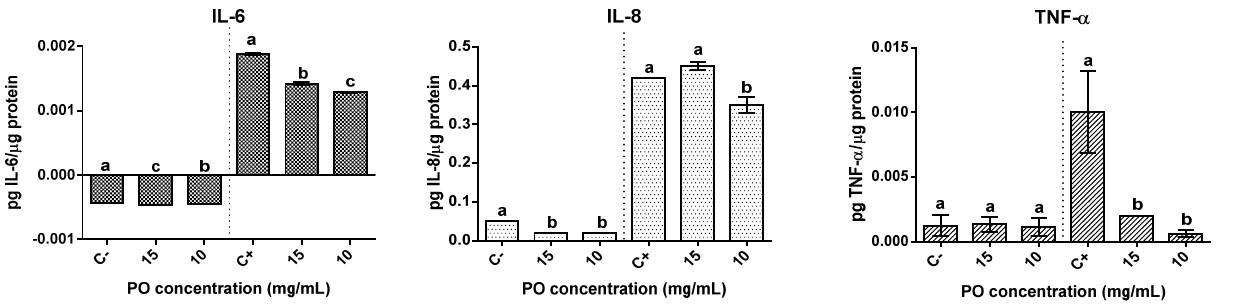
Figure 5. Modulation of inflammatory response in Caco-2 cells by pomegranate oil. The left part of all graphs corresponds to the non-stimulated cell’s response, and the right is related to the anti- inflammatory effect. Different letters represent significant differences as determined by the one-way ANOVA test ( p < 0.05).